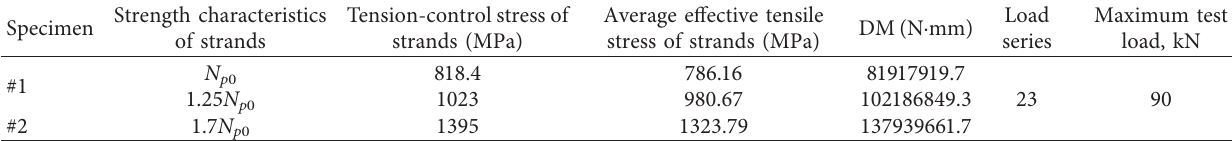
Table 1: Summary of the investigated system parameters.